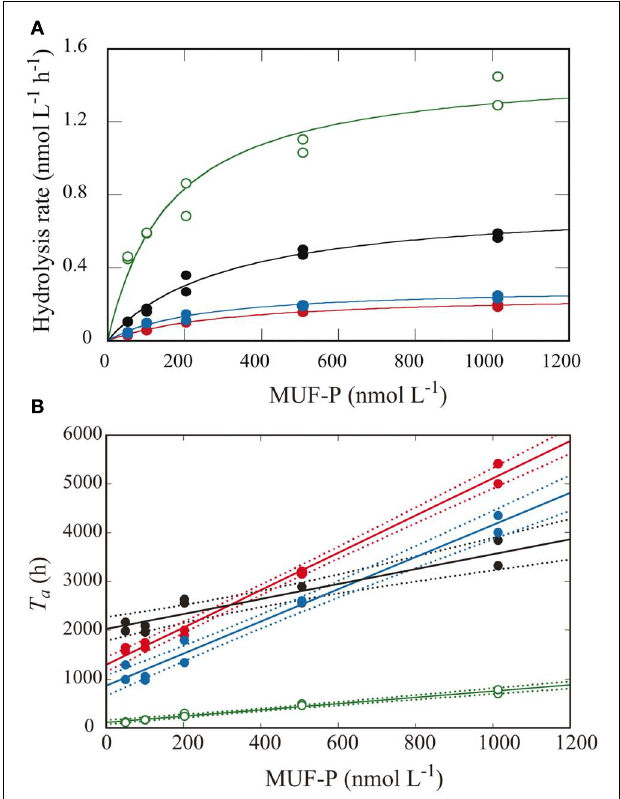
FIGURE 3 | Kinetic analysis ofAPA using the multiple-concentration method in samples from the CML at each station. Lines and symbols are the same as in Figure 2 . (A) APA as a function of added MUF-P concentration using Michaelis–Menten kinetics. (B) Turnover time of the added MUF-P as a function of added MUF-P concentration, with the fitted regression lines (solid) and 95% confidential intervals (dotted lines).